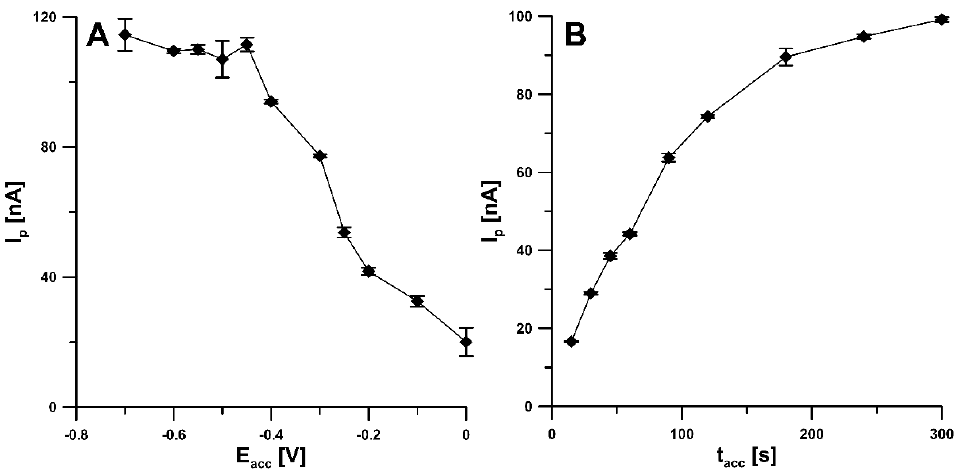
Figure 6. Influence of Eacc ( A ) and tacc ( B ) on the analytical signal of 1.0 and 0.5 nM RIF, respectively.